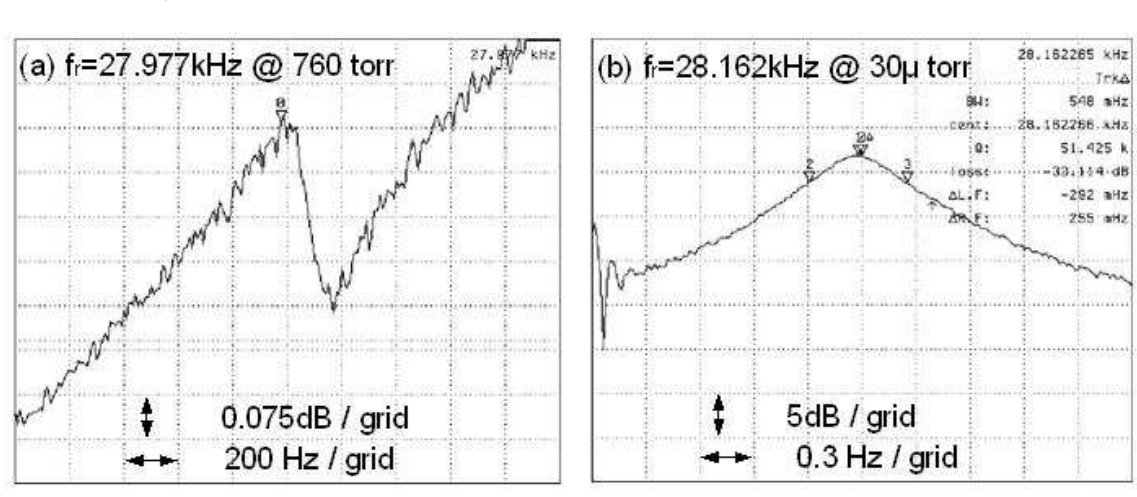
Figure 6. Magnitude plots for a device tested at: (a) atmospheric pressure and (b) 30 µ Torr. Note that the amplitude scale in (a) is smaller than (b) and larger than (b) for the frequency scale because the Q in (a) is much smaller at atmospheric